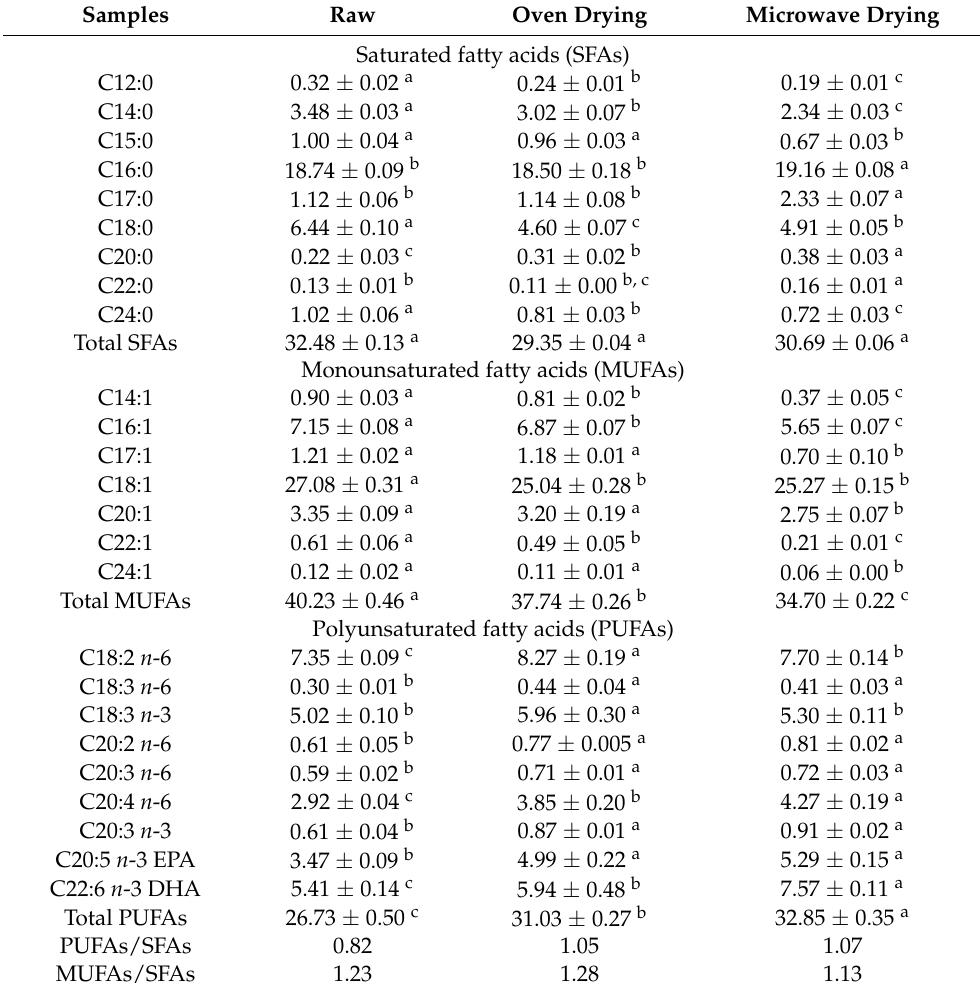
Table 4. Fatty acids composition (%) of raw, oven, and microwave drying of bighead carp H. nobilis